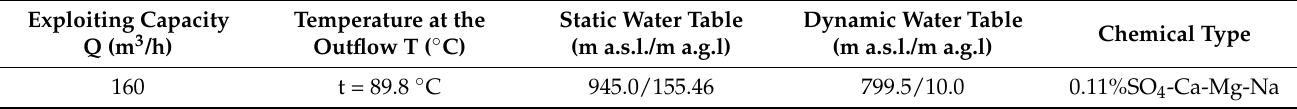
Table 1. Characteristics of the Chochoł ó w PIG-1